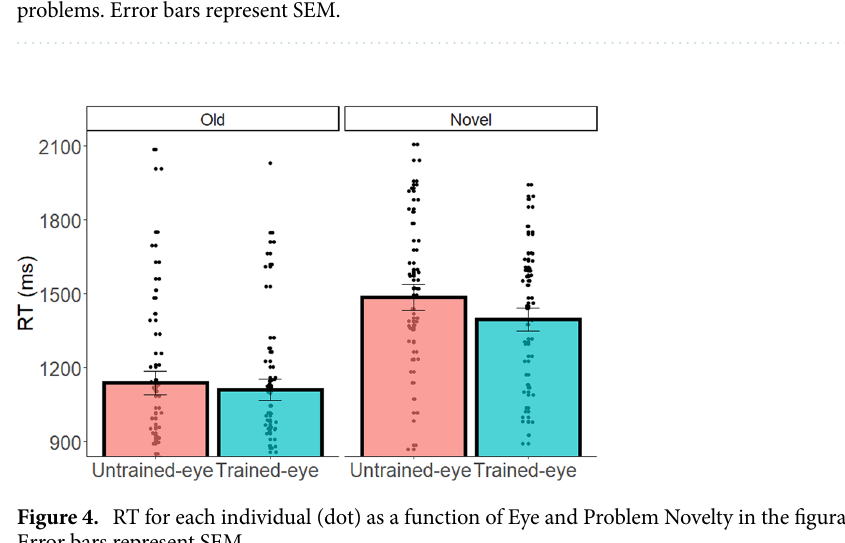
Fig. S2 for the learning curve data during training). Neither the multiplication task nor the Stroop task showed that training led to an eye-specific effect (see Table S1).